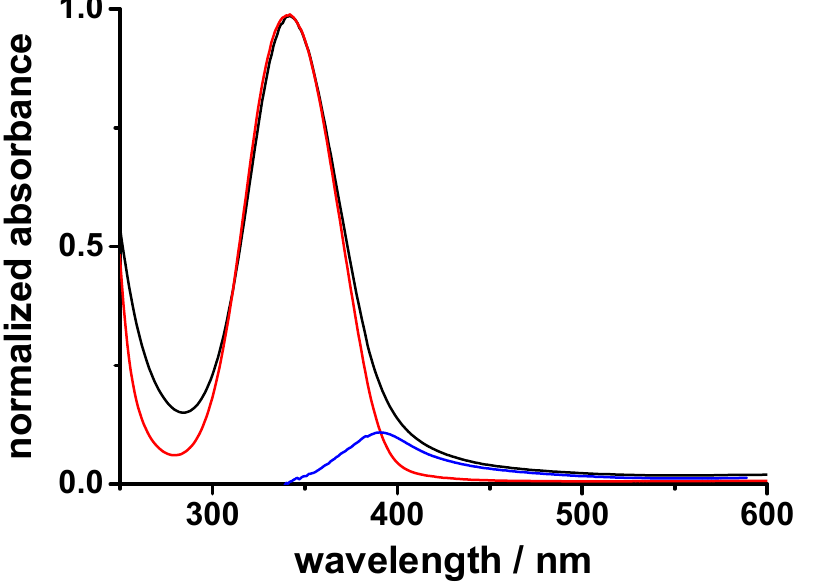
Figure 5. UV–vis absorption band A of 1 mg mL − 1 water solution of N-CDs-160-8 fully reduced with hydrazine (black line); [N-CDs-160-8] 0+ component (red line); NO-CDs component (blue